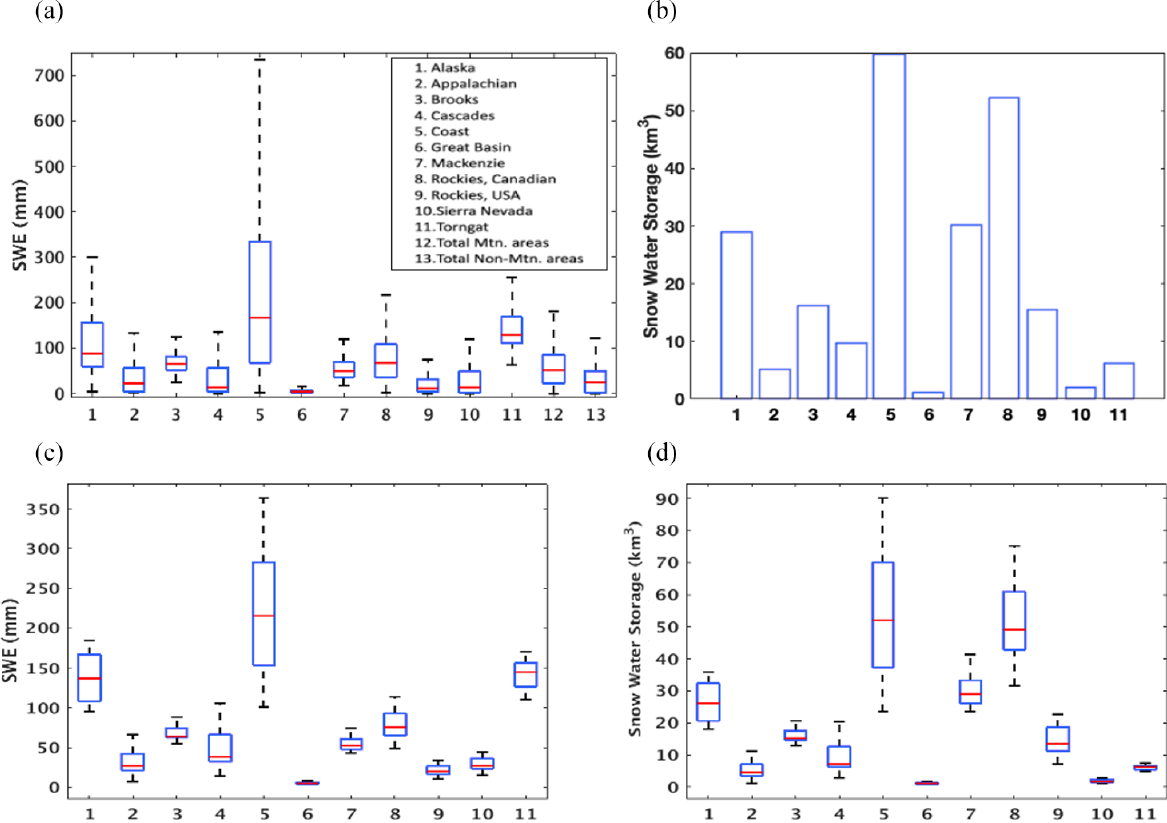
Figure 7. (a) Spatial variability of ensemble mean SWE (in millimeters) within each mountain range. Red line indicates SWE median; top and bottom of box are the 75th and 25th percentiles, and top and bottom of whiskers represent maximum and minimum SWE with outliers (defined as more than 1.5 times the interquartile range, between 25% and 75%) omitted. (b) Total snow water storage (SWS; in cubic kilometers) within each mountain range, computed from the average of ensemble mean SWE over the entire time period. The spread of ensembles for (c) domain- and time-averaged SWE and (d) time-averaged SWS for the different mountain